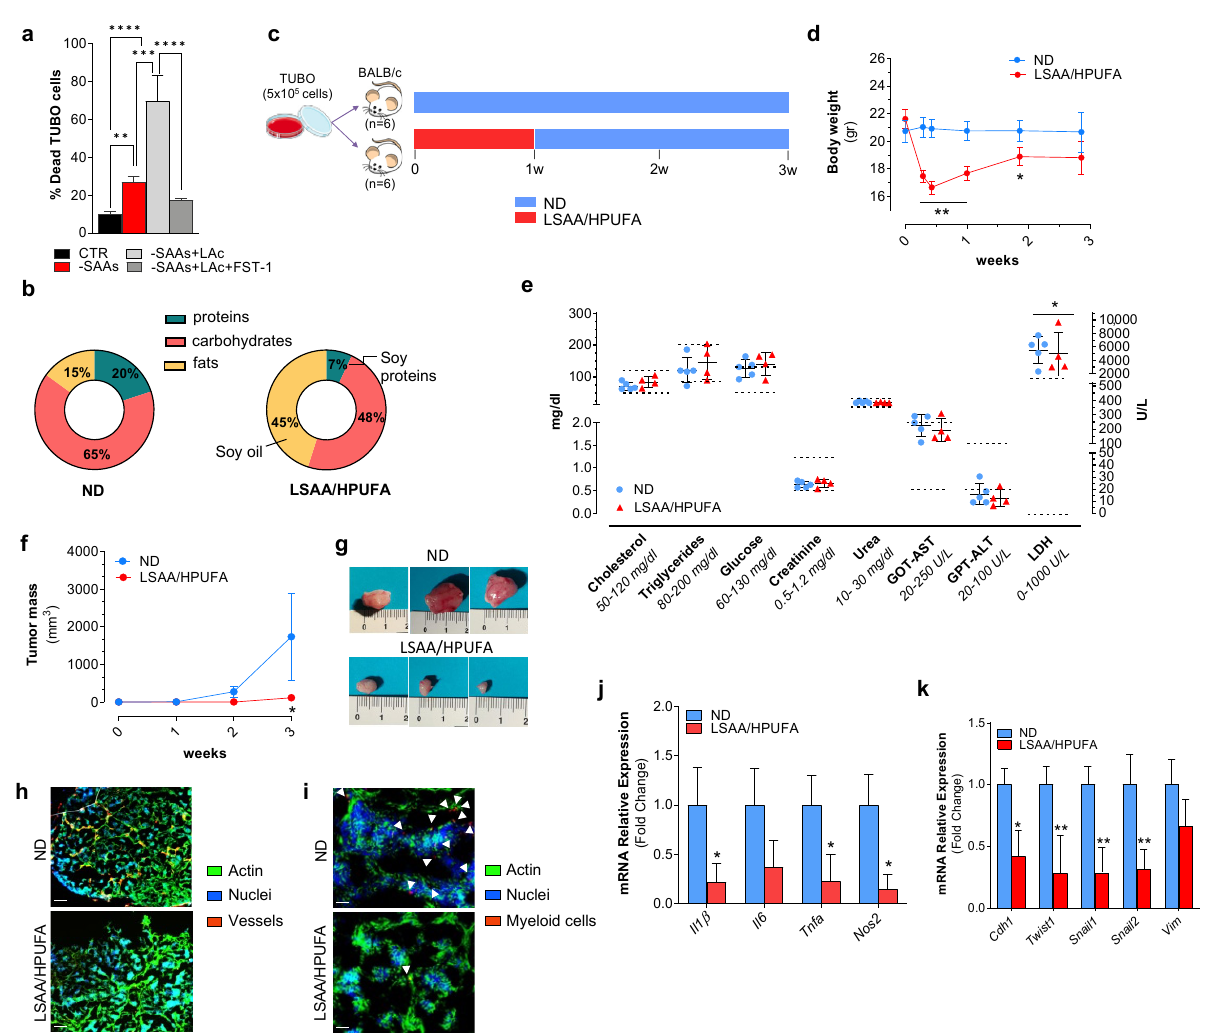
Figure 3. Reducing sulfur amino acids (SAAs) and increasing peroxidizable polyunsaturated fatty acids (PUFAs) through diet counteracts breast cancer development in mice. ( a ) Percentage of dead TUBO cells after 24 h SAAs depletion with or without 400 µ M linoleic acid (LAc). Ferrostatin-1 (FST-1) was used at 5 µ M concentration and added 1 h prior treatment. Data are expressed as mean ± S.D. ( n = 4, ** p < 0.01, *** p < 0.001, **** p < 0.0001). ( b , c ) Schematic representation of normal (ND) and low SAA-high PUFA (LSAA/HPUFA) diet composition ( b ) and experimental design of the in vivo study ( c ). ( d ) Body weight was evaluated weekly until to sacrifice (** p < 0.01, * p < 0.05). ( e ) Analysis of bio-clinical parameters after 3 weeks from TUBO cell injection in mice. Dashed lines indicate the range of normal values. Data are expressed as mean ± S.D. ( n = 5 mice ND group; n = 4 mice LSAA/HPUFA group; * p < 0.05 vs. ND). ( f ) Tumor masses were evaluated weekly until to sacrifice. ( g ) Representative photographs of explanted breast cancer masses. ( h , i ) Representative immunofluorescence images of intratumor vessels ( h ) and immune cell infiltrates ( i ) detected by using Von Willebrand and S100A9 antibody, respectively. Incubation with AlexaFluor488-conjugated phalloidin and Hoechst 33342 were used to visualize actin cytoskeleton and nuclei, respectively. White arrows in ( i ) indicate the presence of myeloid cells within the tumor mass. Scale bar: 100 µ m. ( j , k ) RT-qPCR analysis of the mRNA expression of the inflammation-related genes Il1b, Il6, Tnfa and Nos2 ( j ) and epithelial to mesenchymal transition genes Cdh1, Twist1, Snail1, Snail2 and Vim ( k ). All the images reported are representative of n = 6 mice/group. Data are expressed as mean ± S.D. ( n = 9 mice/group; ** p < 0.01, * p < 0.05 vs.